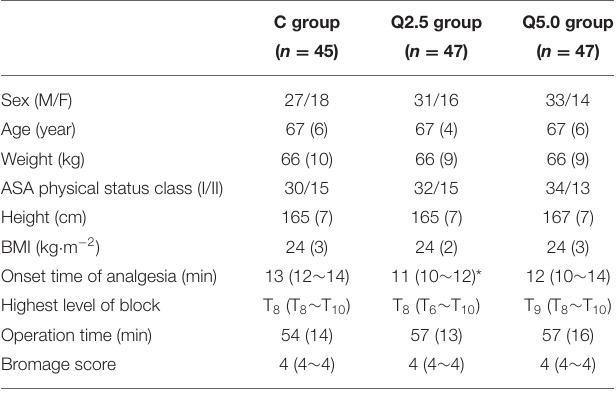
TABLE 1 | Demographic data and patients’ characters. C group Q2.5 group